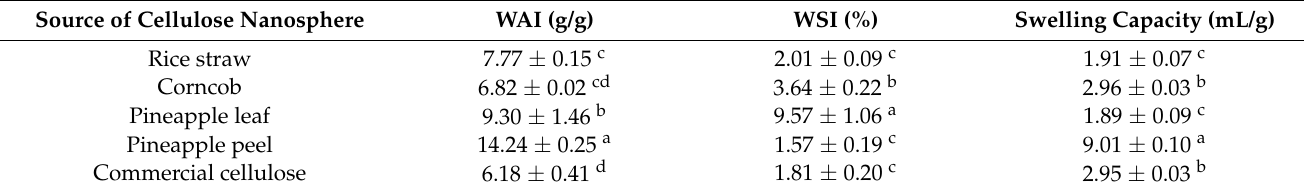
Table 3. Functional properties of cellulose nanosphere from different sources compared with com- mercial